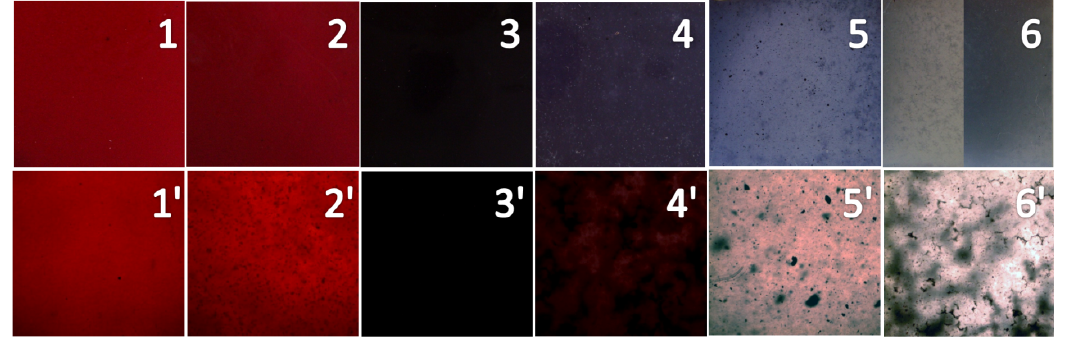
Figure 10. Photographs of PP samples colored with the CaCO CaCO /APRB mixture ( 2 ), the BaSO 3 Ca (PO ) -ABB6B hybrid ( 5 ), and the Ca 3 4 2 PP samples, 1 ′ -6 ′ are images ( × 100) of the PP samples under the